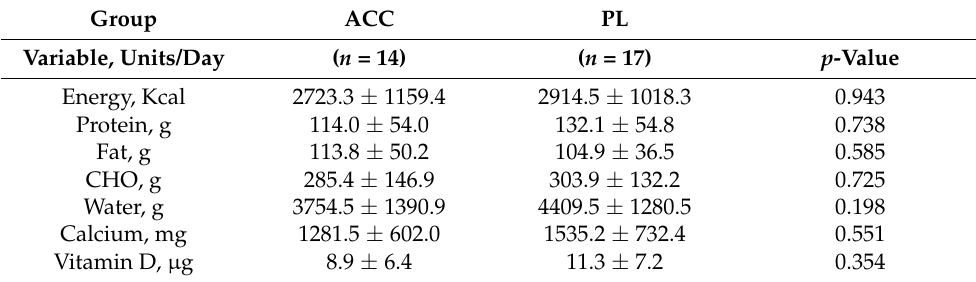
Table 3. Mean ( ± SD) daily micro- and macronutritional consumption values of the ACC and the PL groups, derived from the FFQ completed at the beginning of the study (two-tailed t -test). Group ACC PL Variable, Units/Day ( n = 14) ( n = 17) p -Value Energy, Kcal 2723.3 ± 1159.4 2914.5 ± 1018.3 0.943 Protein, g 114.0 ± 54.0 132.1 ± 54.8 0.738 Fat, g 113.8 ± 50.2 CHO, g Water, g 3754.5 ± 1390.9 Calcium, mg 1281.5 ± 602.0 1535.2 ± 732.4 Vitamin D, µ g 8.9 ± 6.4 11.3 ±